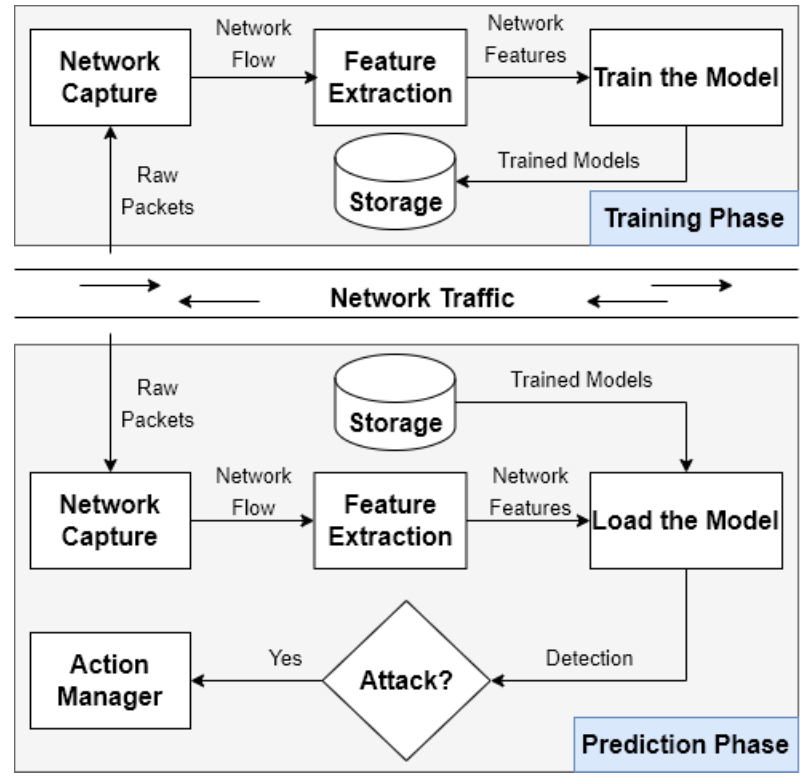
Figure 1. Main operational phases of